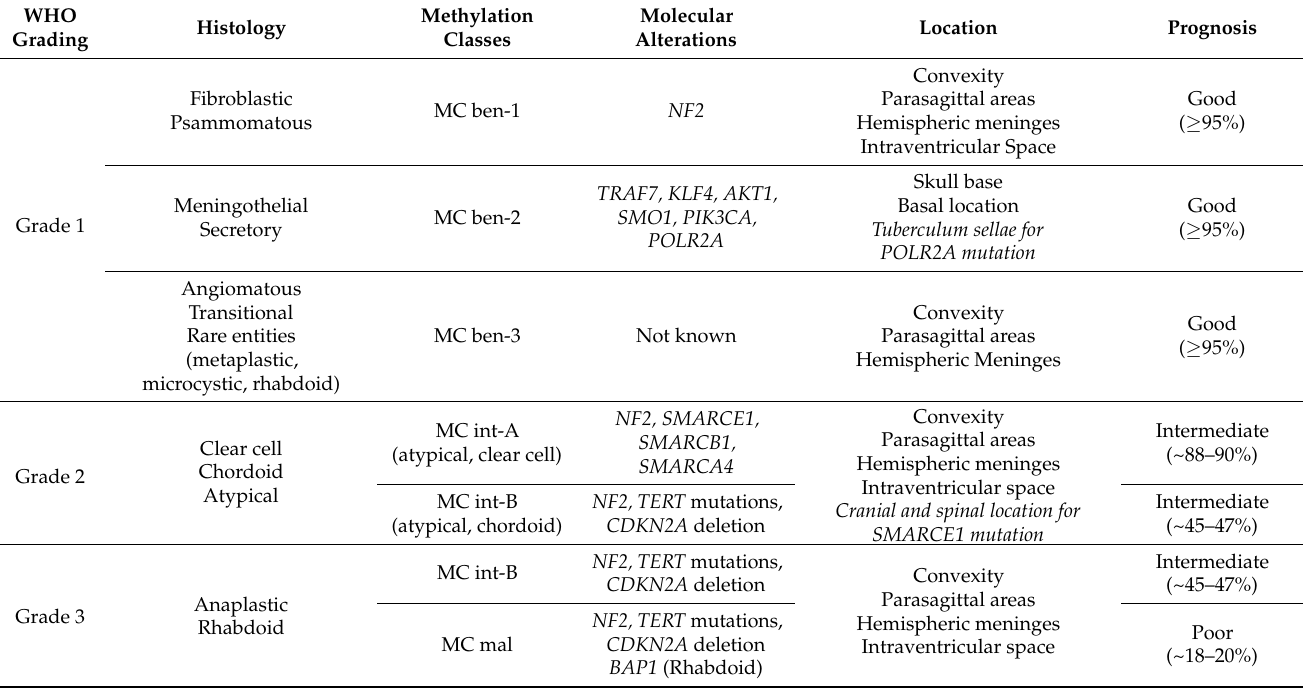
Table 1. Correlations of WHO grading with histology, methylation classes, molecular alterations, location, and prognosis of